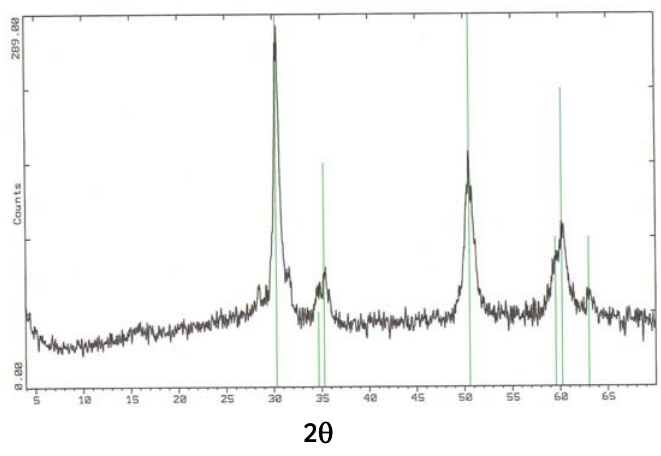
Figure 1. Diffraction pattern of sulfated zirconia